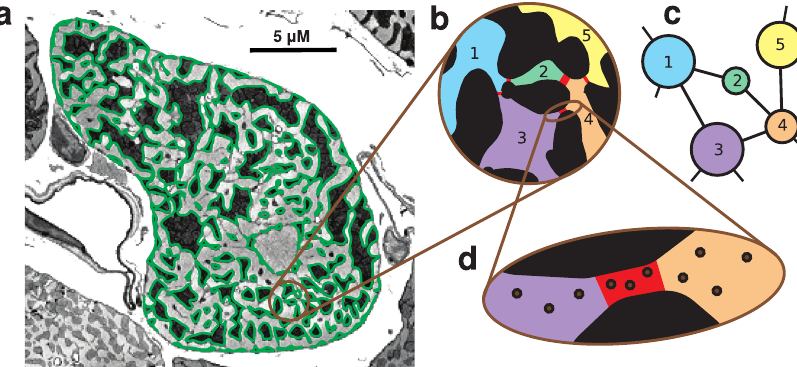
Fig. 1 Complex environments and their networked representations. a An electron-microscopy image highlighting the substructures within a cardiomyocyte cell. The highlighted dark grey regions are mitochondria which act as barriers to macromolecular transport. This image was provided by the Cell Structure and Mechanobiology Laboratory at the University of Melbourne. b The free space within a subsection of the cardiomyocyte is segmented into fi ve distinct reservoirs, connected by narrow channels highlighted in red. c The natural networked topology arising from the cell segmentation. d Macromolecules (small circles) experience stronger crowding effects within the